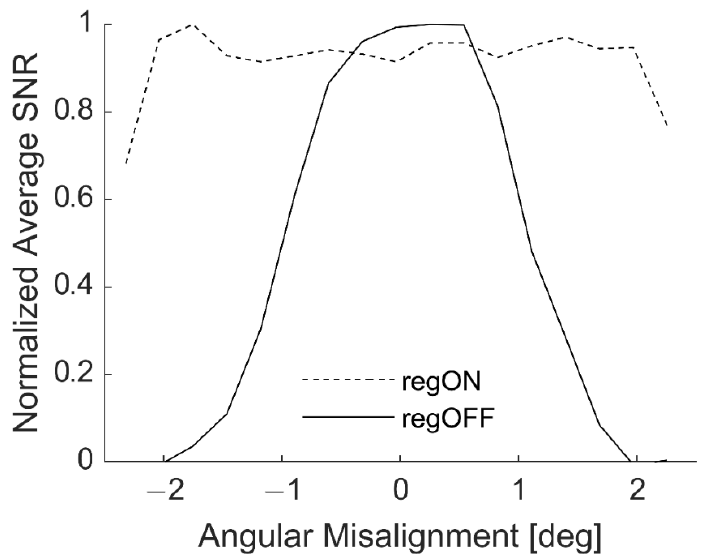
Figure 6. Normalized average signal-to-noise ratio (SNR) across a B-scan at different angular misalignments with regulation ON (regON) and regulation OFF (regOFF).